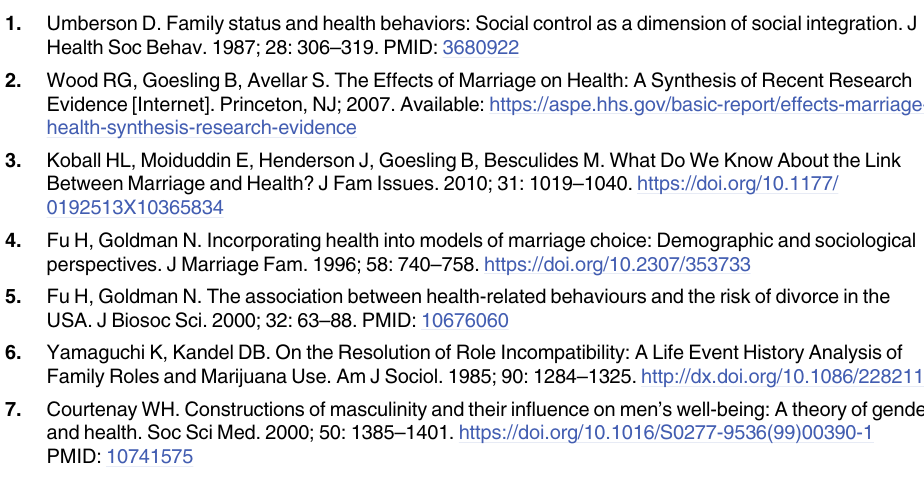
S2 Table. Distribution of parents’ health behavior variables at child’s birth by baseline marital status and sample status. Source : Fragile Families and Child Wellbeing Study. Note : Statistically significant (p < .05) differences between sample and non-sample couples within marital status are denoted by (cid:3) . Married and cohabiting couples at the child’s birth are not included in our sample if they separate before the 1-year survey or if either parent did not com- plete a 1-year